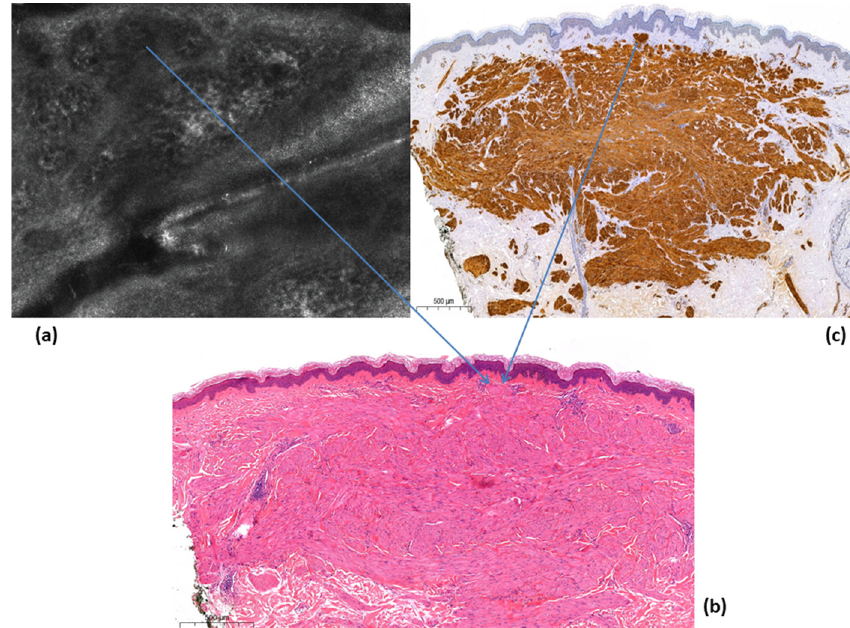
Figure 3. ( a ) Reflectance confocal microscopy (RCM) showed a general unspecific pattern with some hyporeflective structures in the upper papillary dermis and multiple ectatic vessels (accelerated blood flow); ( b ) the histology showed a leiomyoma, and the arrow indicates the superficial dermal propagation up to where the muscle bundles of the tumor reach, which corresponds to the multiple hyporeflective structures that were highlighted in RCM (Hematoxylin and Eosin, 50×); ( c ) the actine immunostain highlighted the bundles of the leiomyoma everted at the level of the superficial dermis that allowed the identification by RCM (Actine immunostain,